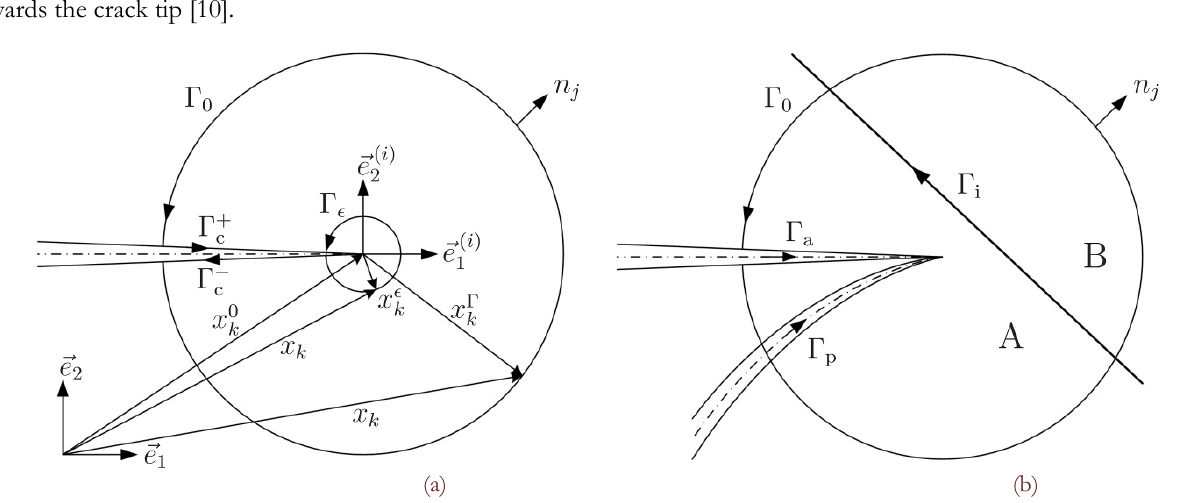
Figure 1: Integration contours, for path-independent J k -, M -, L and I k -integrals, considering physical ( faces and a material interface (